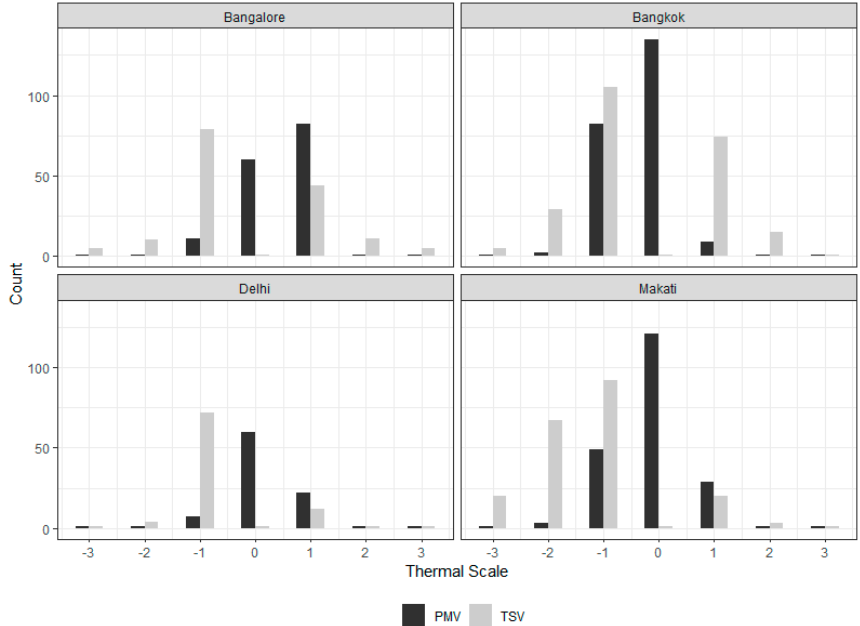
Figure 2. TSV and PMV of building occupants in the ASHRAE global database for Bangalore, Bangkok, Delhi, and Makati on the ASHRAE seven-point thermal scale.